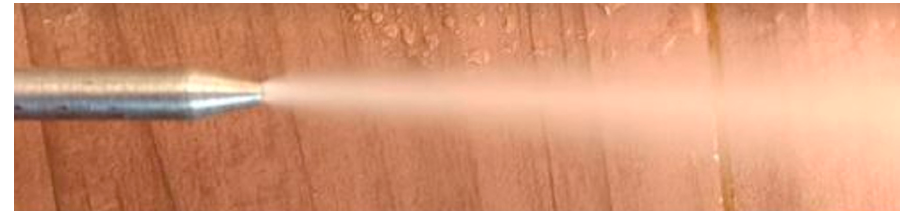
Figure 5. Needle and jet of Superfluido 3.